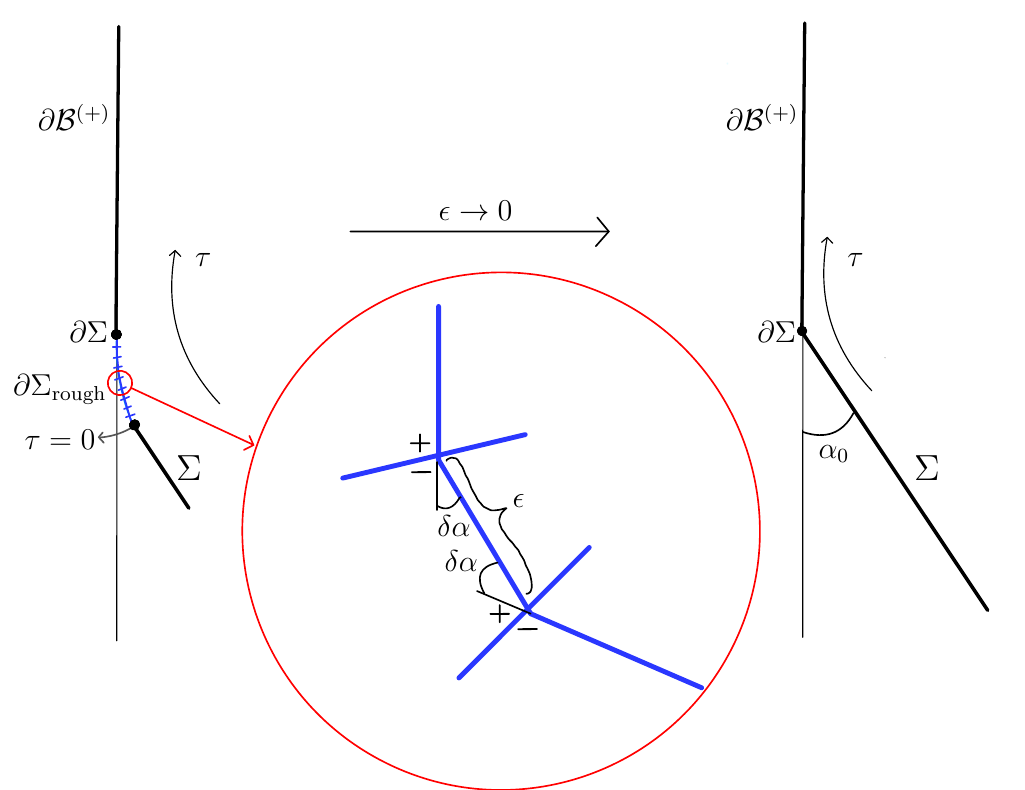
Figure 11 . This figure shows how to get from an infinitesimal angle to a finite angle via successive kinks. In the limit that the proper size (cid:15) of each segment is taken to 0, we have that α = Nδα , where N is the number of kinks, which will be taken to ∞ while keeping α fixed. At each kink we can perform the infinitesimal kink analysis, with the notion of (+) and ( − ) being updated at each step. Working to leading order in (cid:15) we can equate A ( − ) with A (+) of each segment.